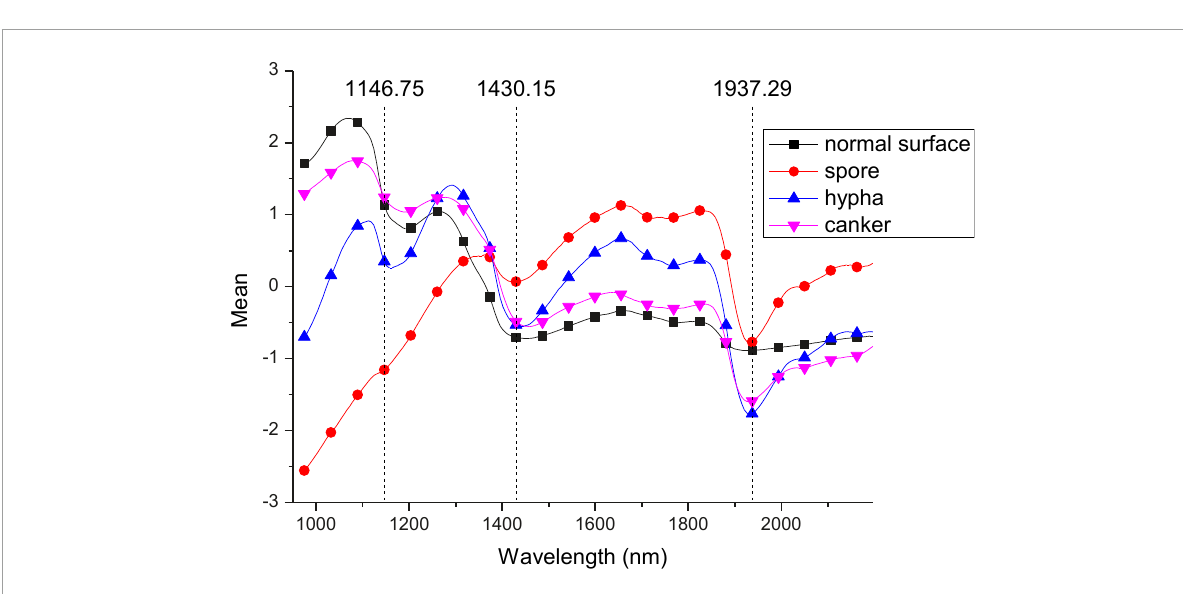
FIGURE6 Spectral curves of the four categories of surface after spherical correction and standard normal variable (SNV) transformation.